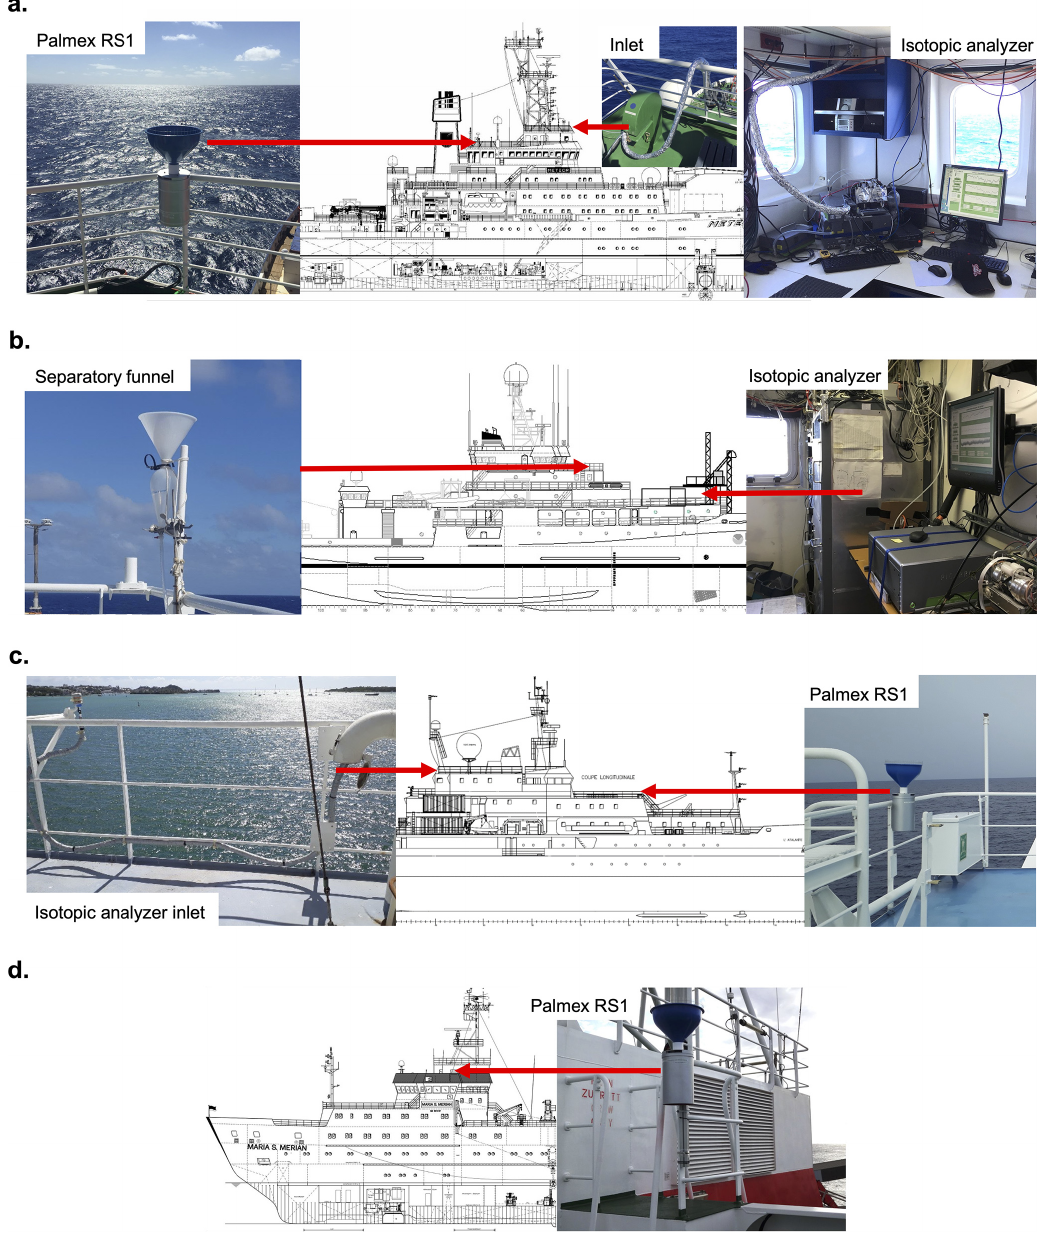
Figure 6. Water isotopic sampling installations aboard (a) the Meteor , (b) the Brown , (c) the Atalante , and (d) the Merian . (The Meteor and Merian ship schematics were provided by University of Hamburg. The Brown ship schematic was provided by NOAA. The Atalante ship schematic is copyright © Ifremer. Atalante photos courtesy of Jérôme